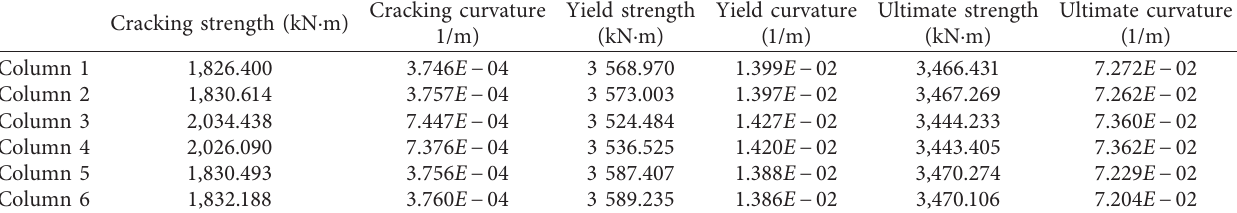
Table 17: Cracking, yield, and ultimate strengths and corresponding curvature values of columns 1–6.